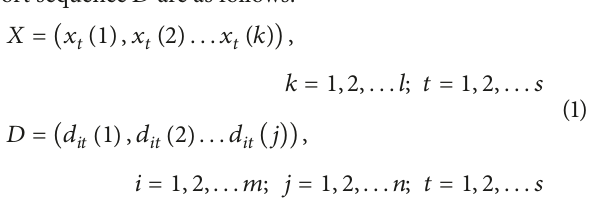
Figure 2: Framework of the two-stage GRA (grey relational analy- sis) method proposed in this